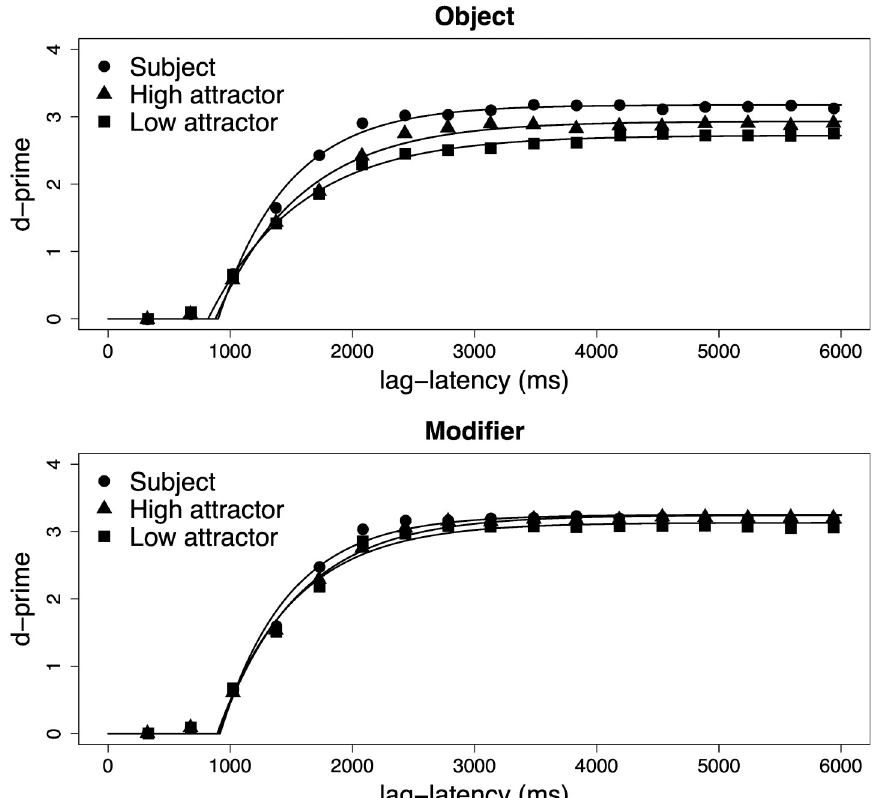
Fig 3. Probe discrimination as a function of lag-latency. The visualization of the Lag-latency/d 0 series was created by aggregating accuracy data, i.e. first collapsing over subjects, then computing d 0 . Plot symbols represent empirical d 0 values and the smooth lines represent the best-fitting